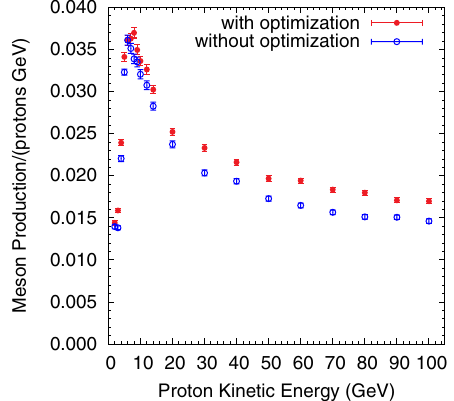
FIG. 7. Production with original geometry and with optimized geometry.